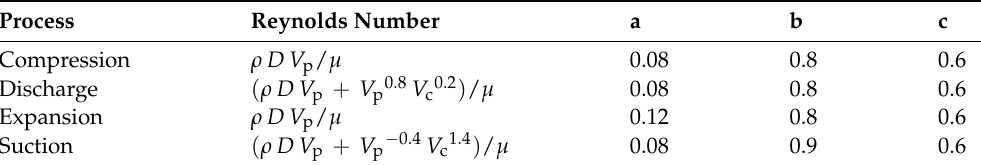
Table 2. The heat transfer parameter values of a diaphragm compressor [29]. Process Reynolds